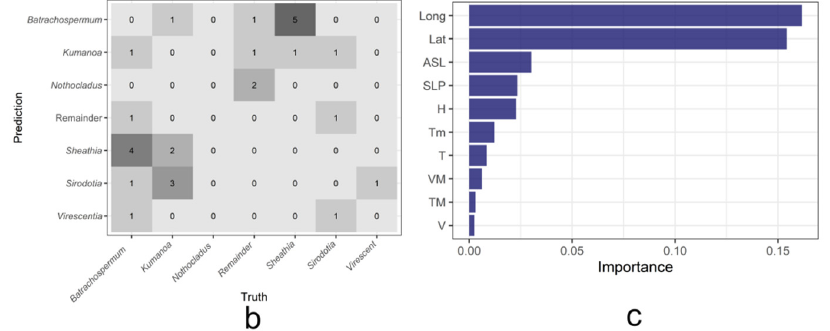
Figure 4. Result of random forest model. ( a ) ROC curve of each genus of random forest model; ( b ) Confusion matrix for random forest model on the validation set; ( c ) Ranking of environmental factor importance for random forest model.